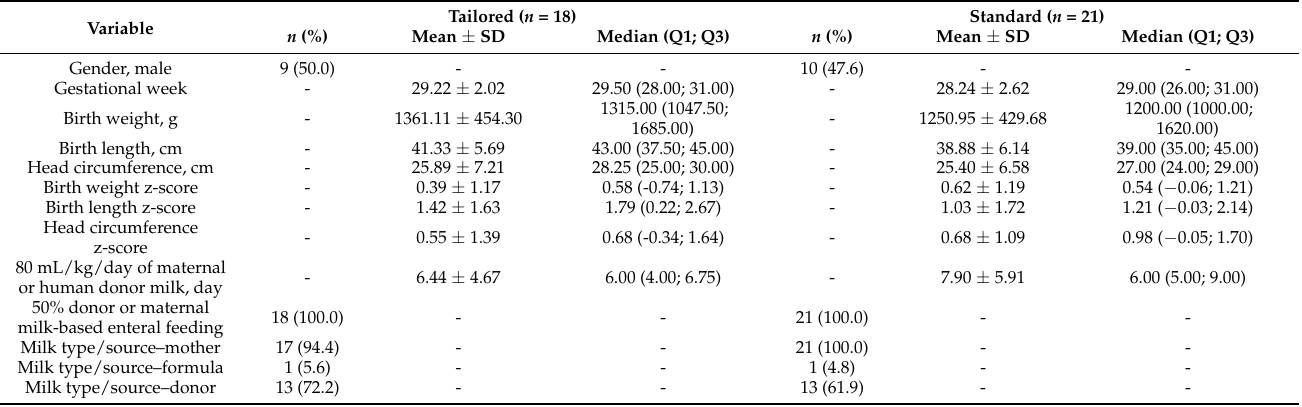
Table 1. Baseline characteristics of study